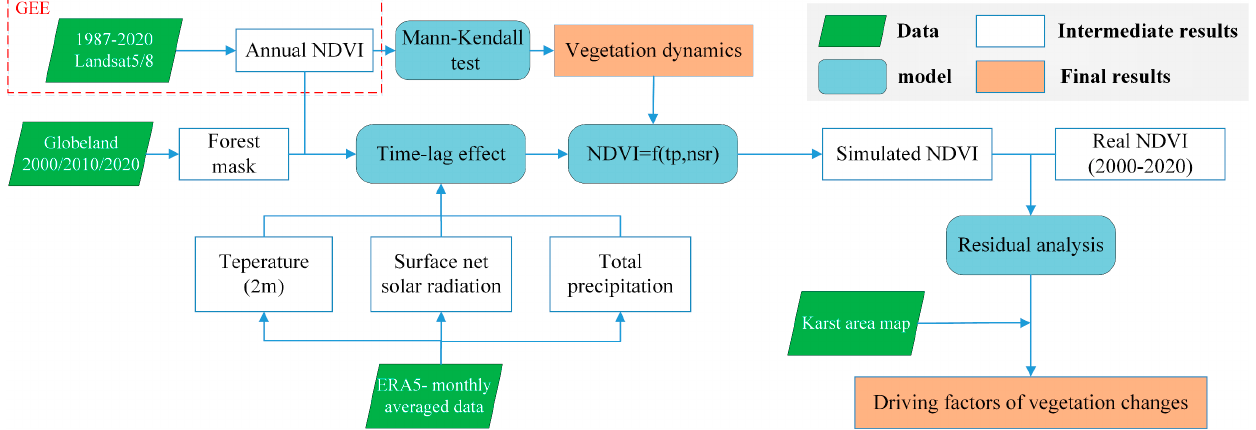
Figure 2. Framework of the research. The green boxes represent data, blue boxes represent model or method, whereas white and orange boxes represent intermediate results and final results, respectively.